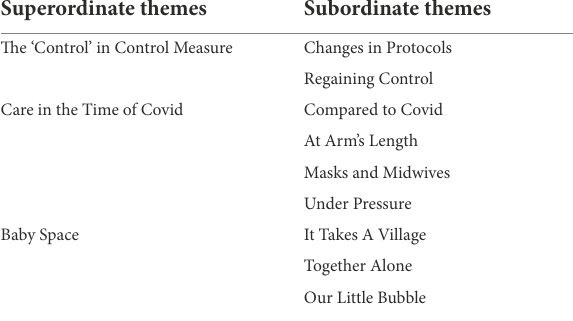
TABLE 2 Superordinate themes and their